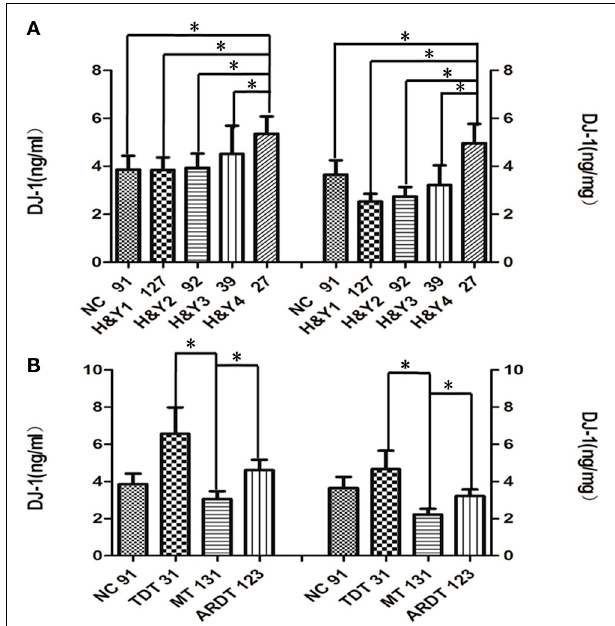
FIGURE 3 | Alteration of salivary DJ-1 in different stages and clinical subtypes of PD. (A) The PD group was divided into four subgroups according to the Hoehn & Yahr staging, and statistical analysis of salivary DJ-1 levels in the different disease stages performed: the DJ-1 levels increased in H&Y-4 stages of PD compared to the other three groups and NC groups (H&Y-1 vs. H&Y-4 p = 0 . 001, H&Y-2 vs. H&Y-4 p = 0 . 003, H&Y-3 vs. H&Y-4 p = 0 . 014, NC vs. H&Y-4 p = 0 . 005, H&Y-1 vs. H&Y-4 p = 0 . 0002, H&Y-2 vs. H&Y-4 p = 0 . 001, H&Y-3 vs. H&Y-4 p = 0 . 014, NC vs. H&Y-4 p = 0 . 005 when normalized). (B) PD patients were classified as tremor-dominant type (TDT), if the tremor score was at least twice the non-tremor score. The patient was classified as akinetic-rigid dominant type (ARDT) if the non-tremor score was at least twice the tremor score. The remaining patients, in whom the tremor and non-tremor scores differed by less than a factor of 2, were classified as mixed type (MT). From the analysis, MT patients had lower DJ-1 levels than the TDT group ( p = 0 . 02, p = 0 . 054 when normalized) and ARDT group ( p = 0 . 016, p = 0 . 032 when normalized) when PD patients were divided into tremor dominant, akinetic, and mixed subtypes. Data shown are mean ± SD. A two tail p -value < 0.05 was defined as statistically